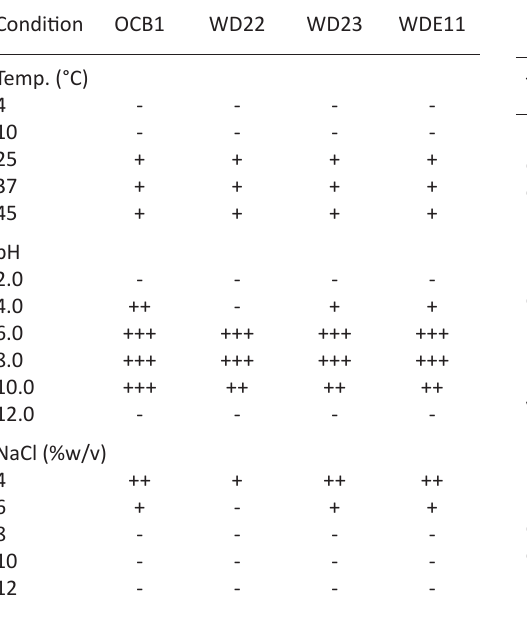
Table 5. Growth of isolated and identified best degraders of PCO at different cultural conditions Culture